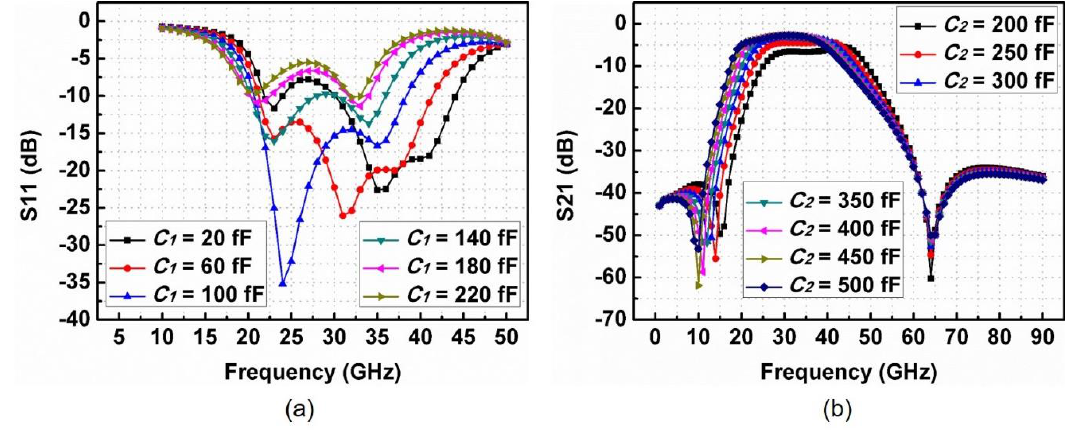
Figure 8. ( a ) S11 variation under different values of C 1 , ( b ) S21 variation under different values of C 2 .